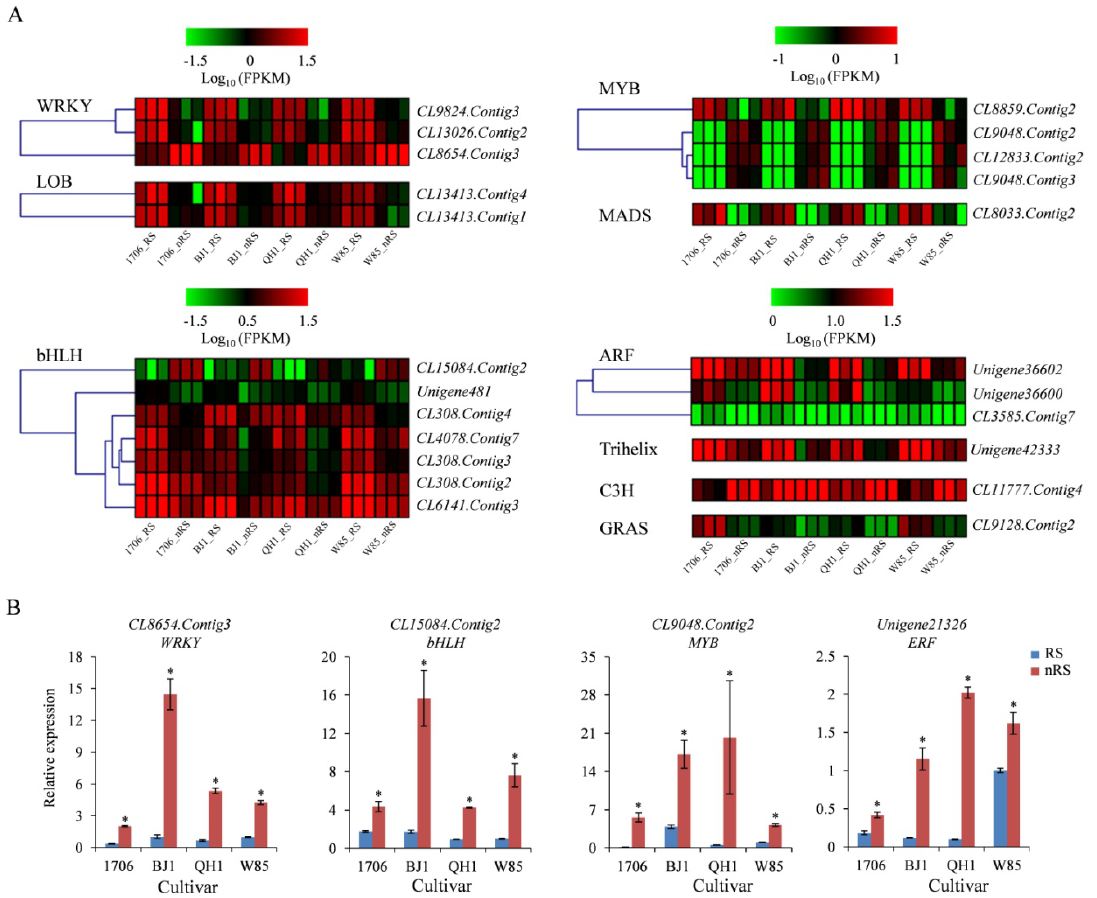
Figure 9. Expression patterns of TFs between non-radial striations than in radial striations of R. glutinosa. ( A ) Heat map representing expression dynamics of unigenes belongs to transcription factor genes. ( B ) Relative expression levels of four transcription factor genes in non-radial striations compared to radial striations from 1706, BJ1, QH1, and W85 by qRT-PCR. Vertical bars indicate the standard deviation of three biological replicates. * indicate a significant difference at the p < 0.05 level.